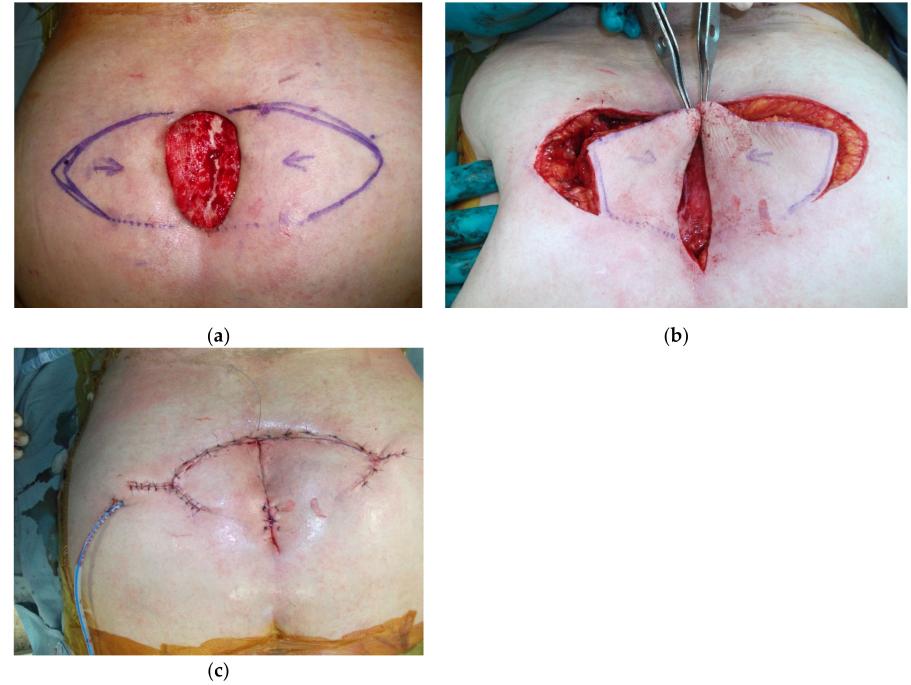
Figure 9. ( a ) Excision of squamous cells carcinoma in the sacral region; ( b ) two elevated VY flaps; and ( c ) result at the end of